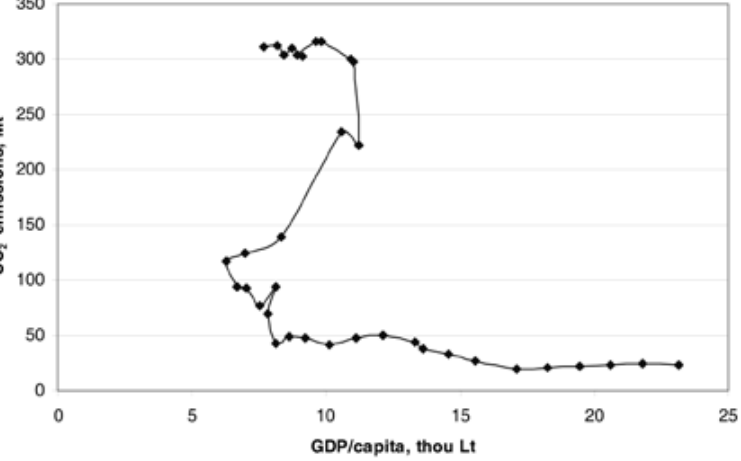
Fig. 1. Lithuanian environmental Kuznets curve, 1980–2015